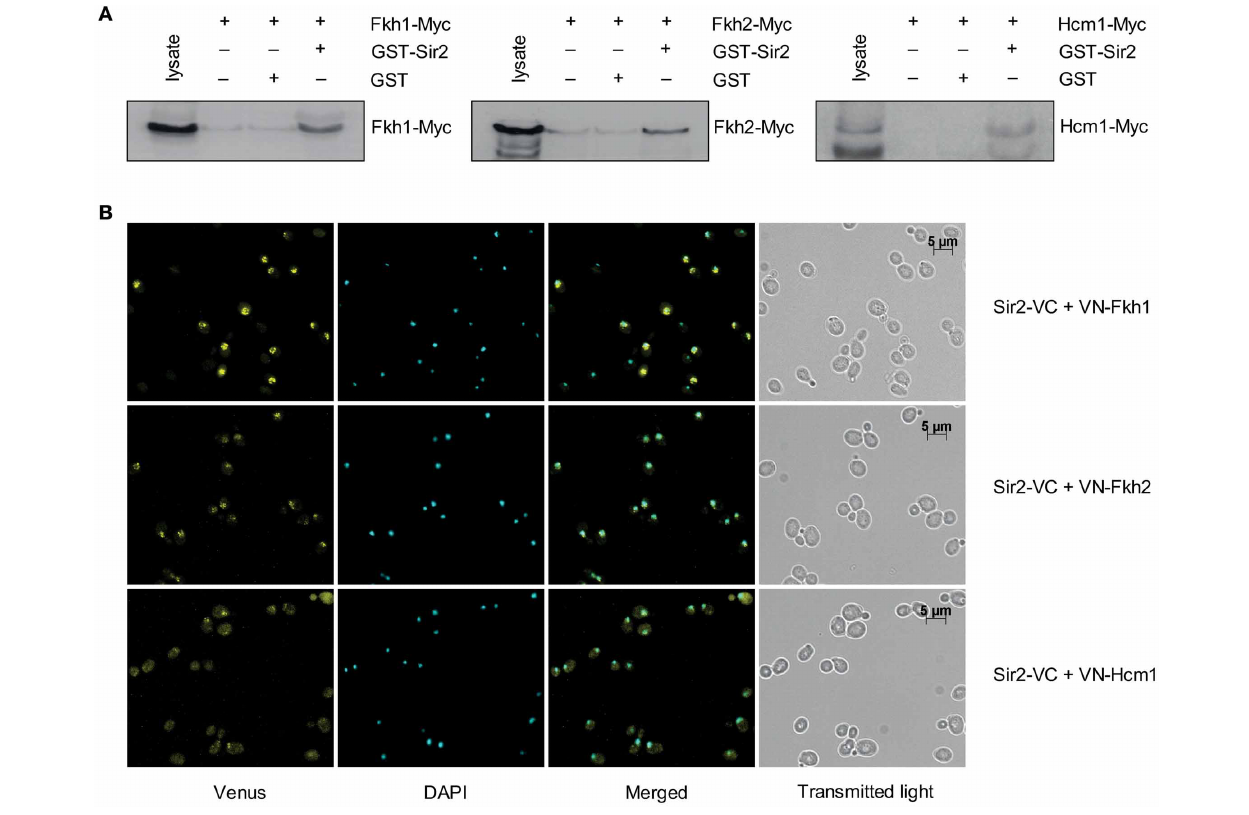
was performed with a mouse α -Myc antibody. (B) BiFC analysis. Yeast cells expressing the fusion protein Sir2-VC were transformed with plasmids encoding the fusion proteins VN-Fkh1, VN-Fkh2, and VN-Hcm1 under the control of the constitutive GPD promoter. Venus signals were